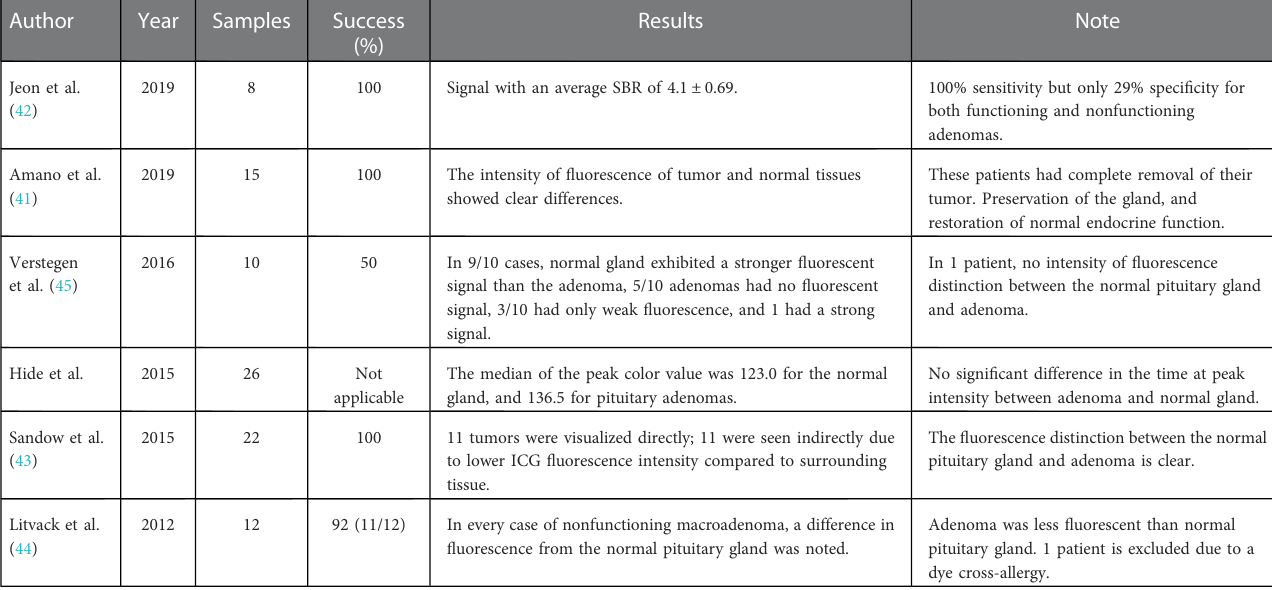
TABLE 2 Characteristics of studies reporting on the use of ICG in pituitary